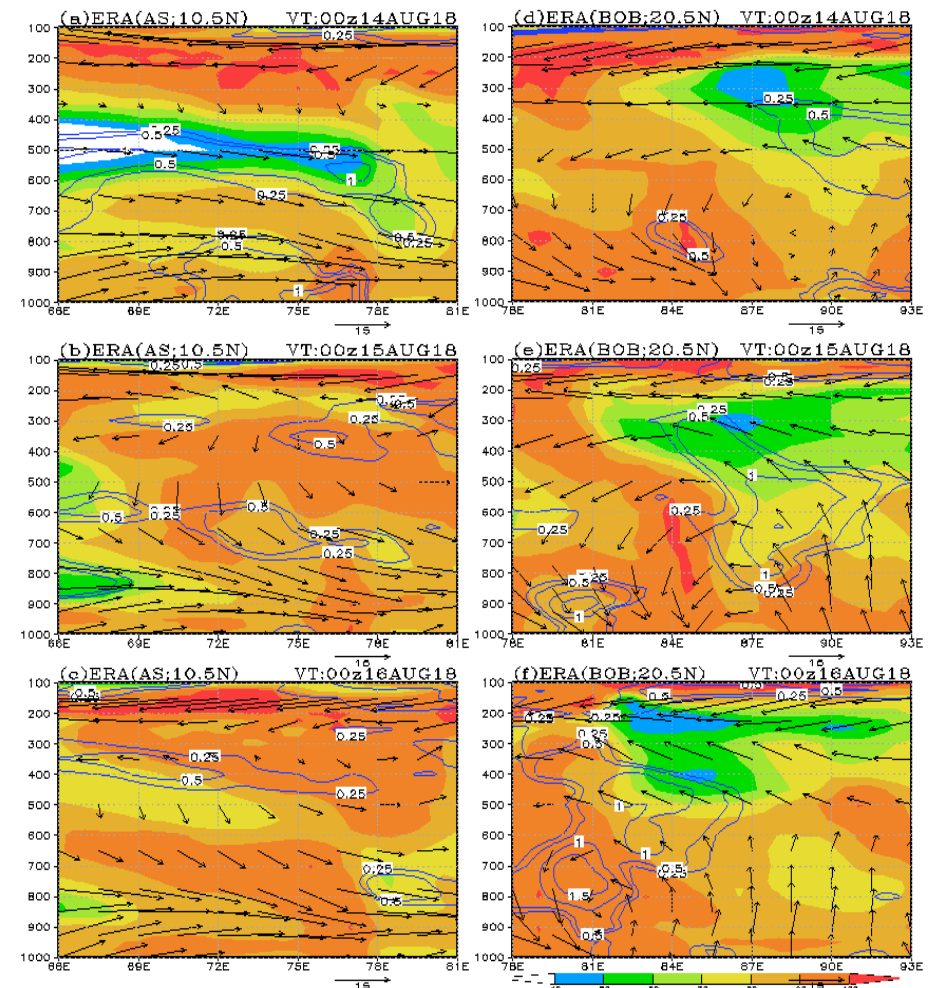
Figure 7. ( a–c ). Longitudinal and pressure level cross-section of the relative humidity (%; shaded), temperature anomaly (°K; blue contour), and wind flow pattern (ms − 1 ) along the coast of the Arabian Sea at 10.5° N valid at 00 UTC on 14–16 August 2018; ( d – f ) are the same as ( a – c ), but for the cross-section over the east coast of BoB at 20.5° N derived from ERA-Interim reanalysis at a 25 km resolution.